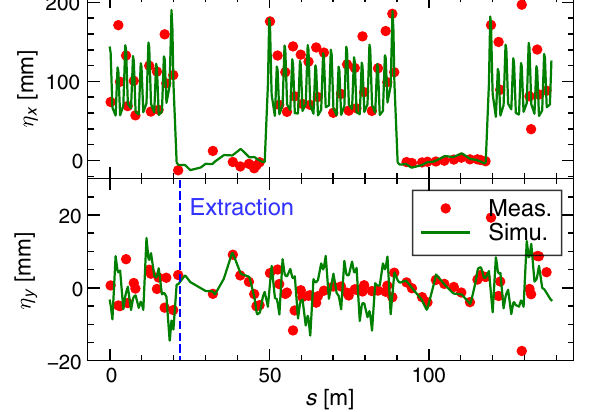
FIG. 7. Measurement and reproduction of horizontal and vertical dispersions of the ATF DR. The equilibrium vertical emittance is about 12 pm in the presence of intra-beam scattering with a bunch charge of 0.16 nC.